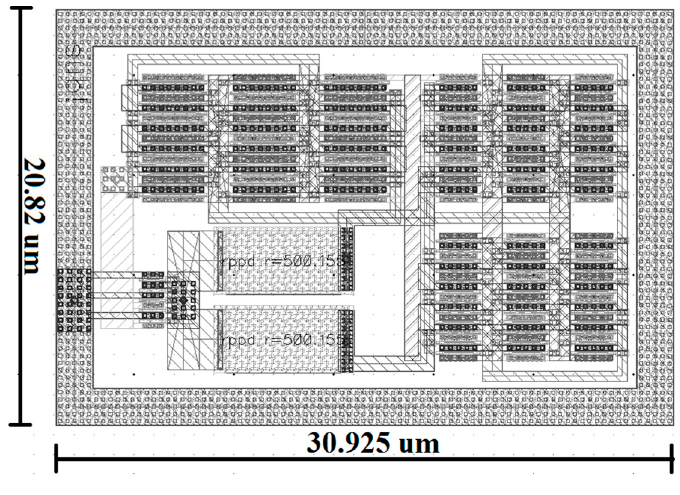
Figure 9. The mixer layout. Table 1. Comparison of the Gilbert cell mixers performance.